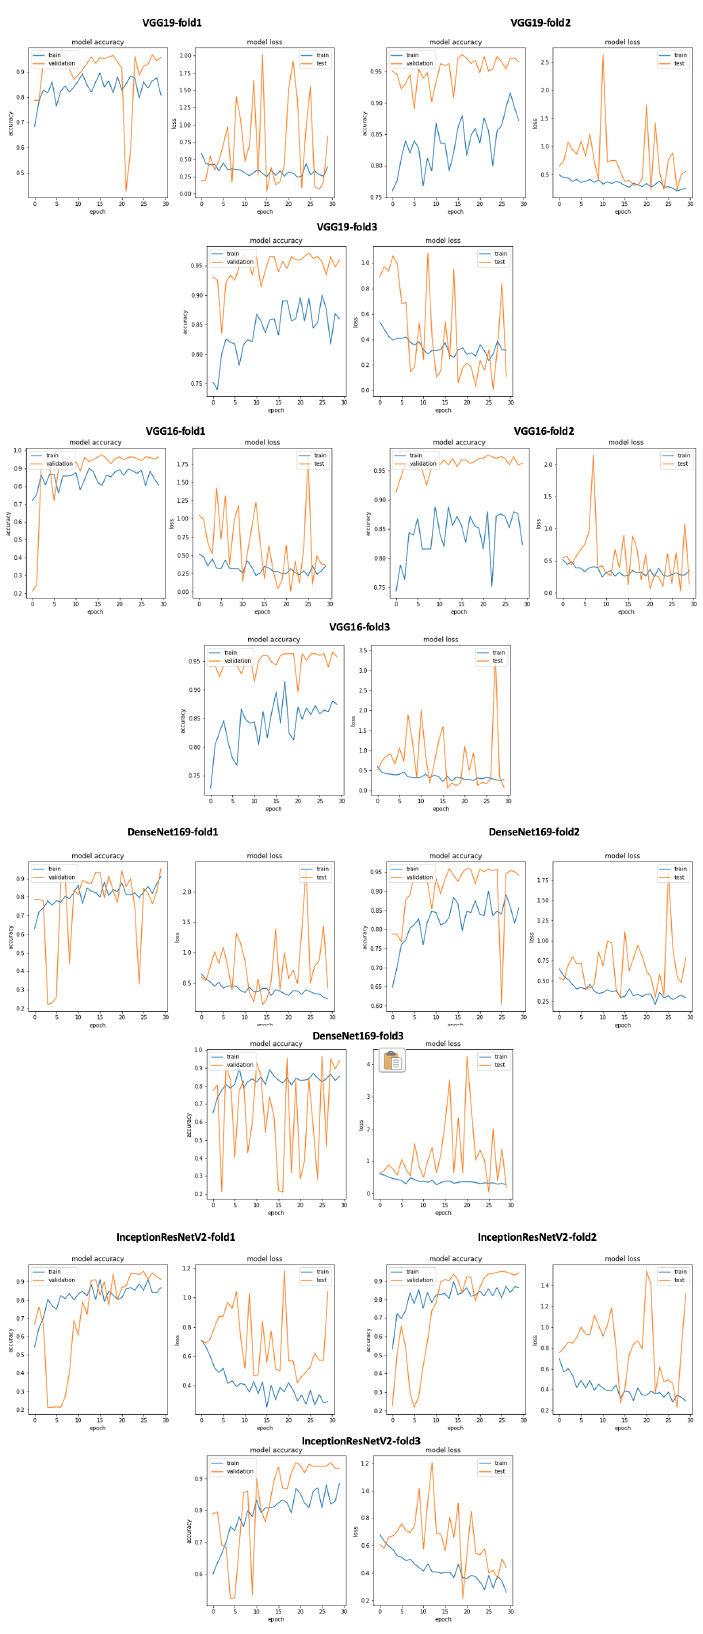
Figure 12. An overview of our approach using VGG19, VGG16, DenseNet169 and InceptionResNetV2 training and validation curves on PhysioNet